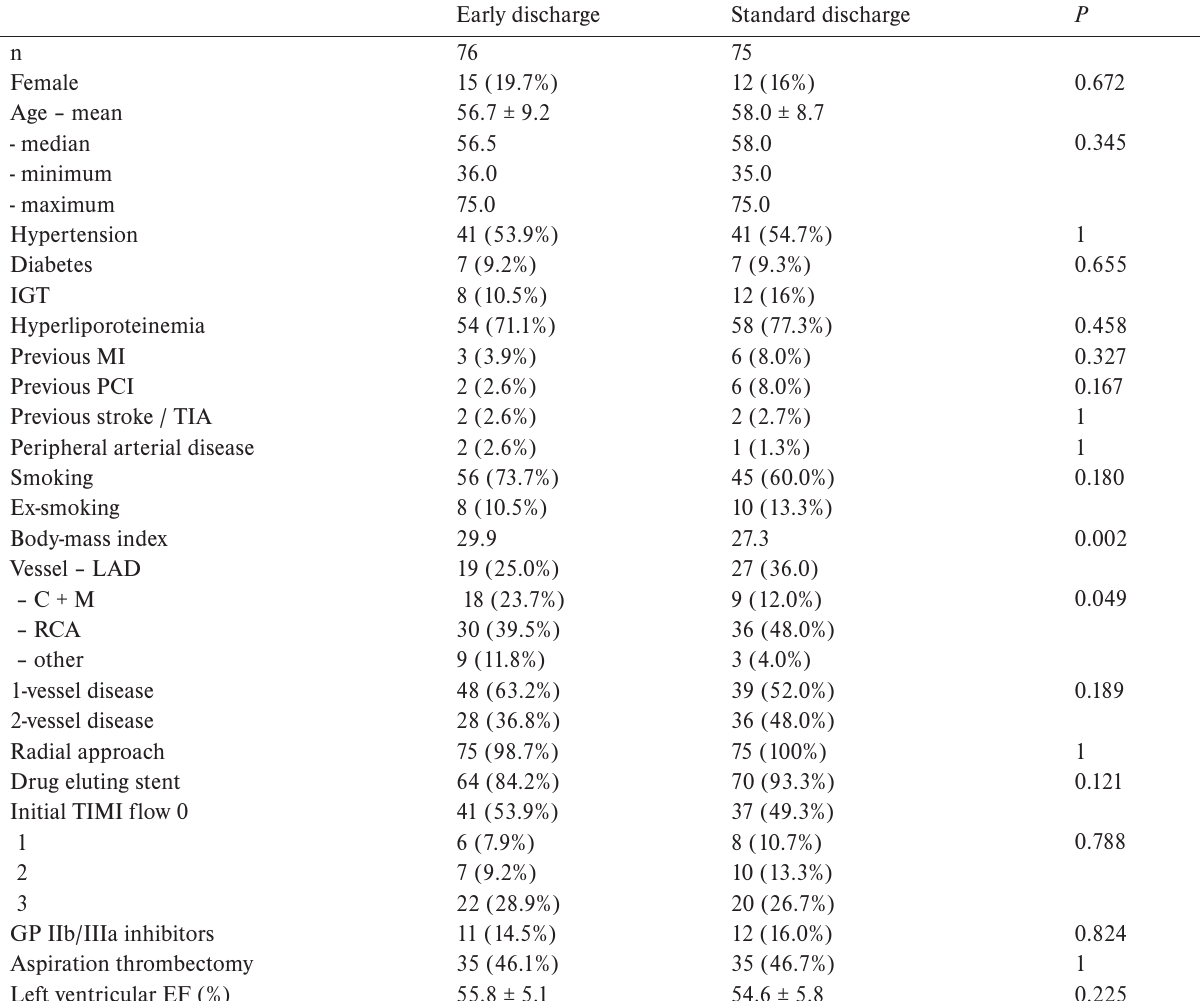
Table 2. Baseline clinical characteristics of the analyzed cohorts. Procedural data of PCI and left ventricular ejection fraction.